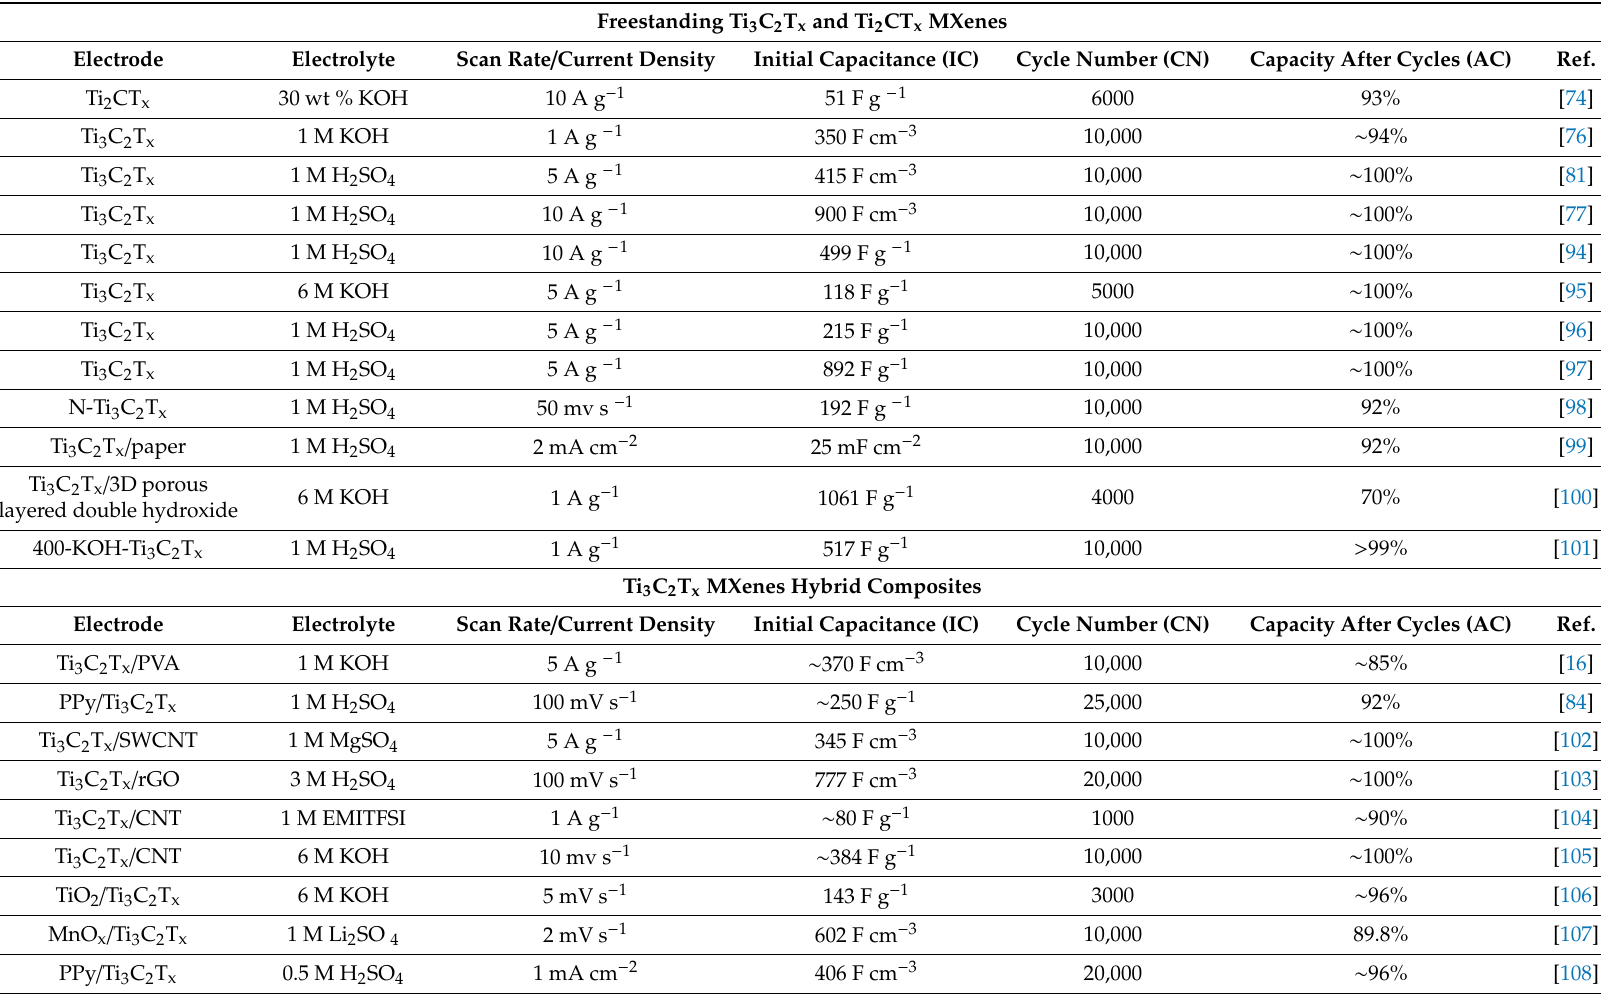
Table 3. Freestanding Ti 3 C 2 T x and Ti 2 CT x MXenes supercapacitors compared to some Ti 3 C 2 T x composites as a function of electrolyte and scan rate / current density. Abbreviations: PPy = polypyrrole, rGO = reduced graphene oxide, CNT = carbon nanotubes, PVA = polyvinyl alcohol, and SWCNT = single-walled carbon